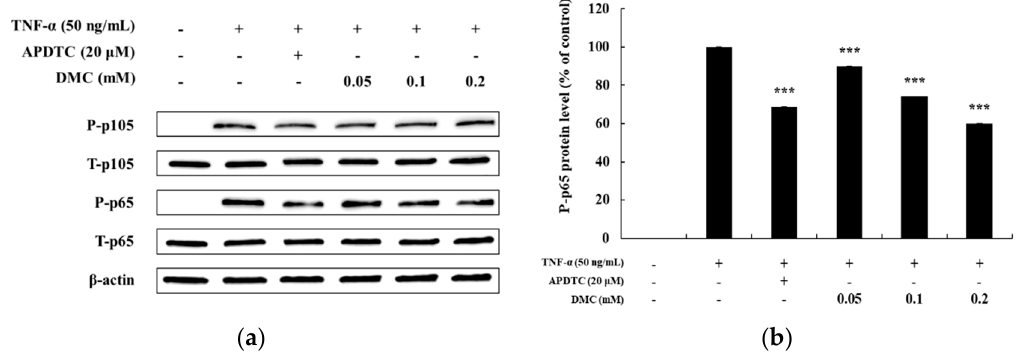
Figure 6. Effect of DMC on p105and p65 expression in TNF- α -treated HaCaT cells. ( a ) Cells were pretreated with various concentrations of DMC (0.05, 0.1, and 0.2 mM) for 1 h and then stimulated with TNF- α for 10 min followed by western blotting of the cell lysates with the indicated antibodies. ( b ) Quantitation of protein level of P-p65 presented as mean ± SD (n = 3). *** p < 0.001 vs. TNF- α - treated control.